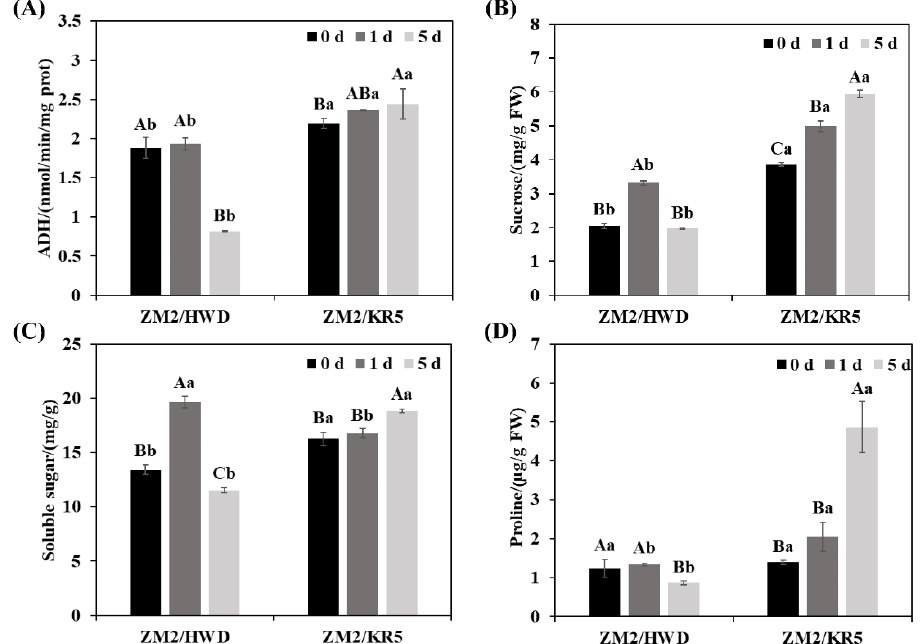
Figure 3. ( A , D ) Superoxide anion (O 2 − ) production rate in leaves and roots, ( B , E ) hydrogen peroxide (H 2 O 2 ) content in leaves and roots, and ( C , F ) malondialdehyde (MDA) content in leaves and roots. ZM2/HWD and ZM2/KR5 indicate grafting ‘ Zhongmi 2 ′ onto ‘ Hayward ’ and KR5 rootstocks, respectively. Data are the mean values ± SD ( n = 3). Capital letters denote significant differences between the different waterlogging treatment stages for each scion–rootstock combination, and lower-case letters denote significant differences among the scion–rootstock combinations within the different waterlogging treatment stages according to a least significant difference (LSD) test ( p ≤ 0.05).